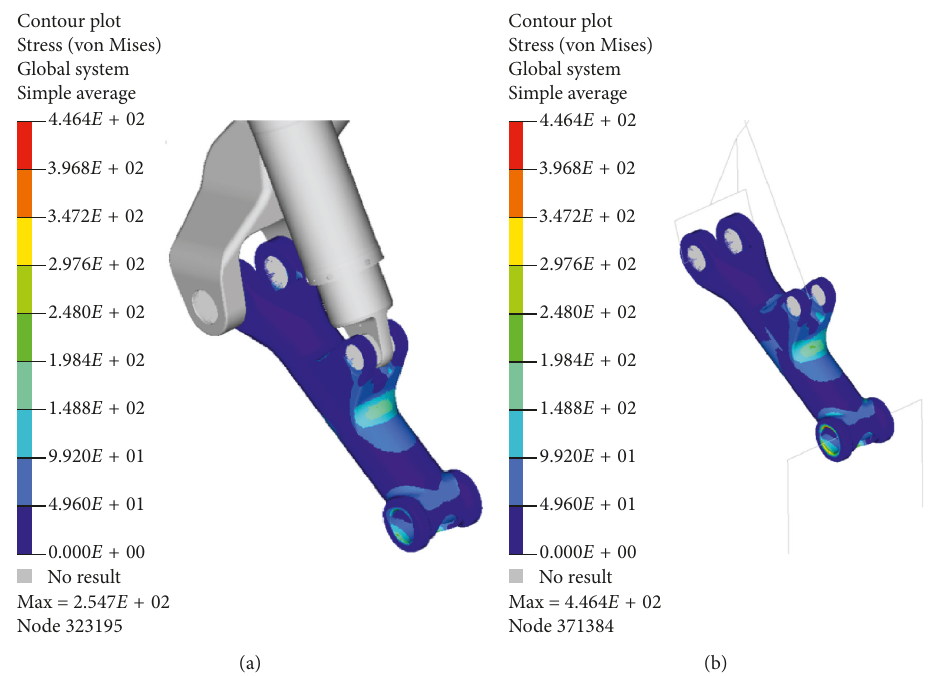
Figure 9: von Mises stresses (MPa) for the trailing arm achieved by (a) 3D full-FE model and (b) Global/local technique.